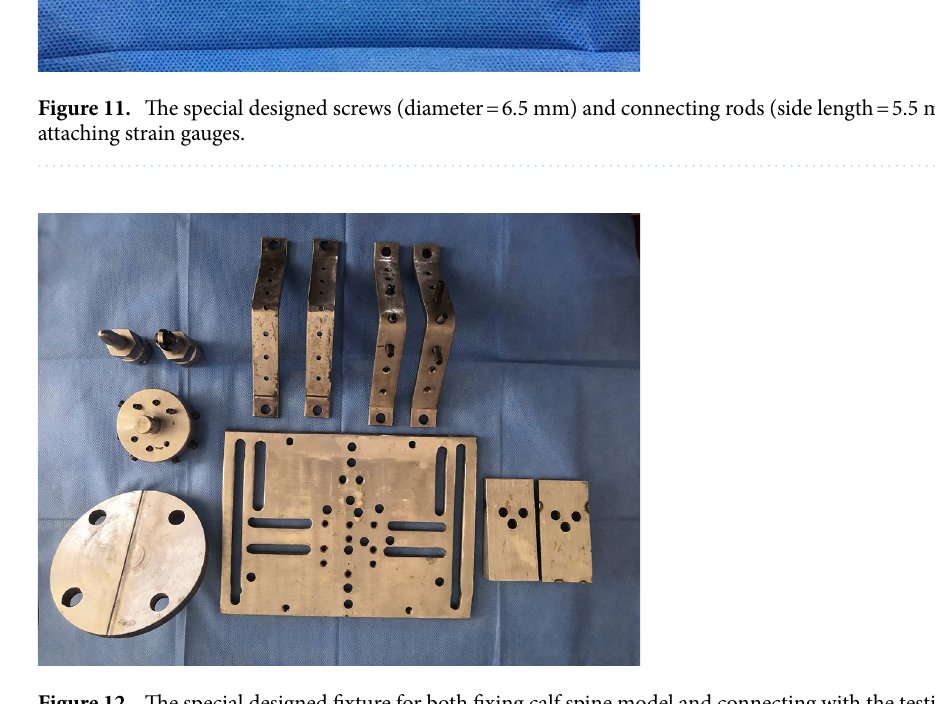
Figure 12. The special designed fixture for both fixing calf spine model and connecting with the testing